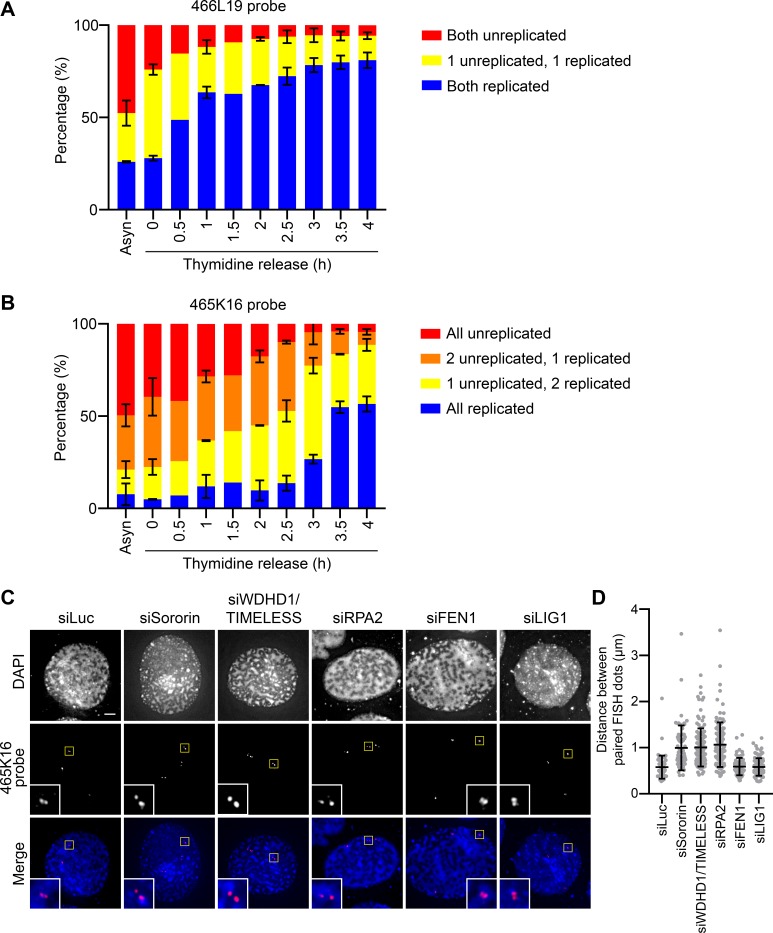
RPA2 promotes sister-chromatid cohesion.(A) Asynchronous cells or cells released from the thymidine arrest for the indicated times were harvested and stained with the 466L19 FISH probe. Quantification of the percentages of cells with two unreplicated single FISH dots (red), cells with one unreplicated FISH dot and one pair of replicated FISH dots (yellow), or cells with two pairs of replicated FISH dots (blue). (B) Asynchronous cells or cells released from the thymidine arrest for the indicated times were harvested and stained with the 465K16 FISH probe. Note that HeLa cells contains three copies of the chromosome locus recognized by this probe. Quantification of the percentages of cells with three unreplicated single FISH dots (red), cells with two unreplicated single FISH dots and one pair of replicated FISH dots (orange), cells with one unreplicated FISH dot and two pairs of replicated FISH dots (yellow), or cells with three pairs of replicated FISH dots (blue). (C) Representative images of G2-enriched HeLa cells transfected with the indicated siRNAs and stained with DAPI (blue in merge) and the 465K16 FISH probe (red in merge). Selected paired FISH signals are magnified and shown in inset. Scale bar, 5 μm. (D) Quantification of the distances between paired FISH signals of cells in C). Mean ±SD (siLuc, n = 65; siSororin, n = 70; siWDHD1/TIMELESS, n = 125; siRPA2, n = 116; siFEN1, n = 67; siLIG1, n = 97).